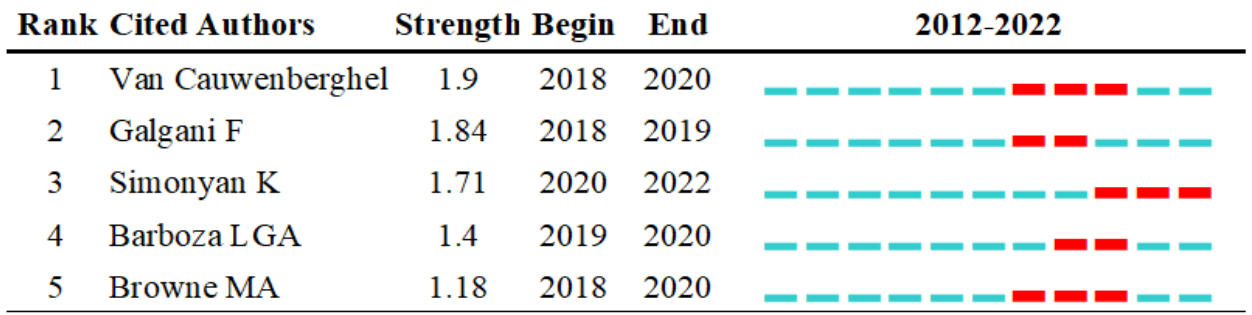
Figure 20. The most cited references.